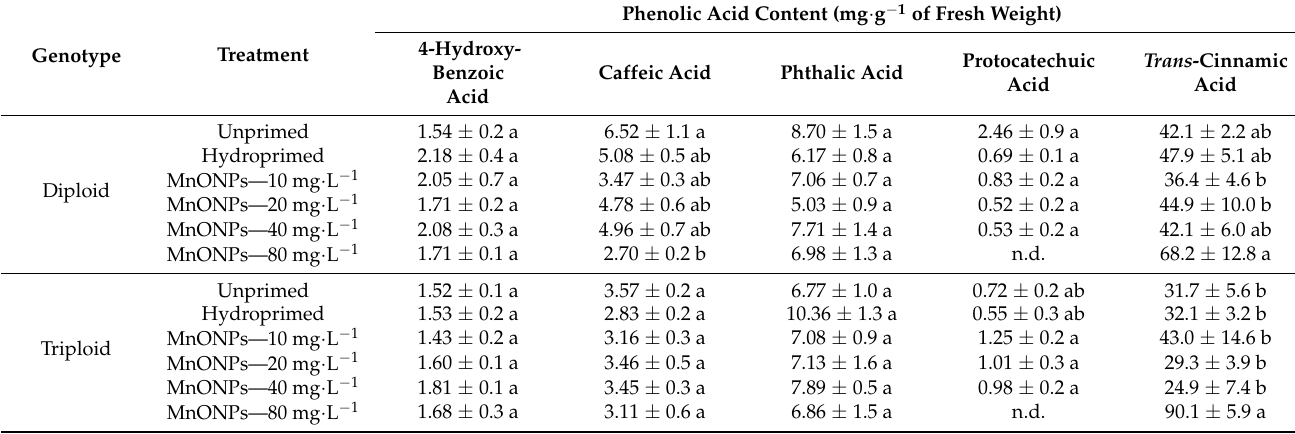
Table 1. The levels of certain phenolic acids in leaf tissue samples of unprimed, hydroprimed, and MnO-NPs-primed diploid and triploid watermelon seedlings. Different letters indicate significance at p < 0.05.